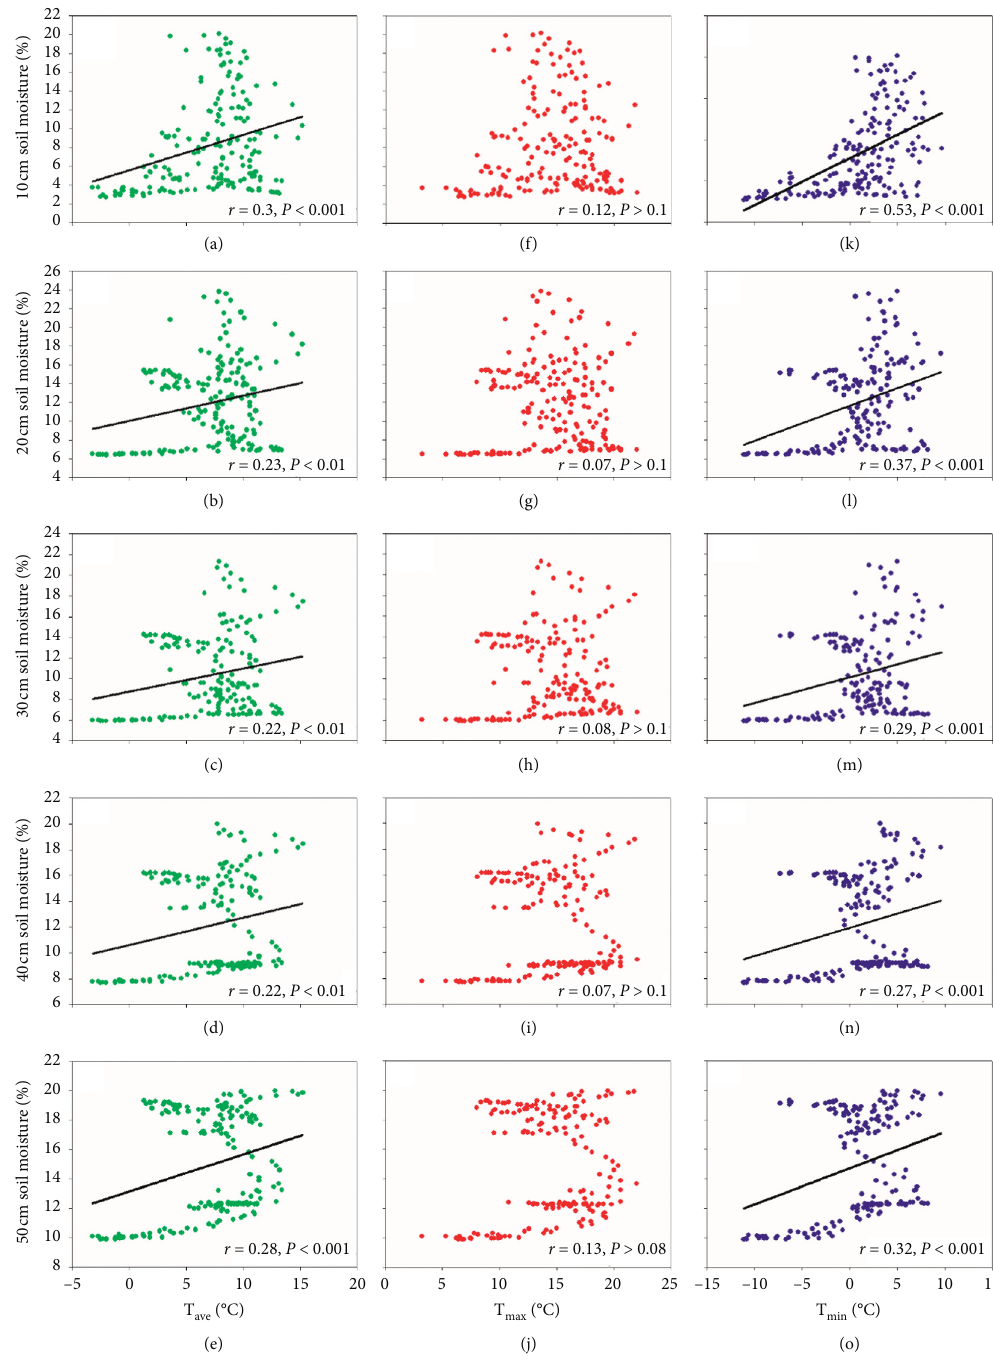
Figure 2: Correlations between air temperature and soil moisture at